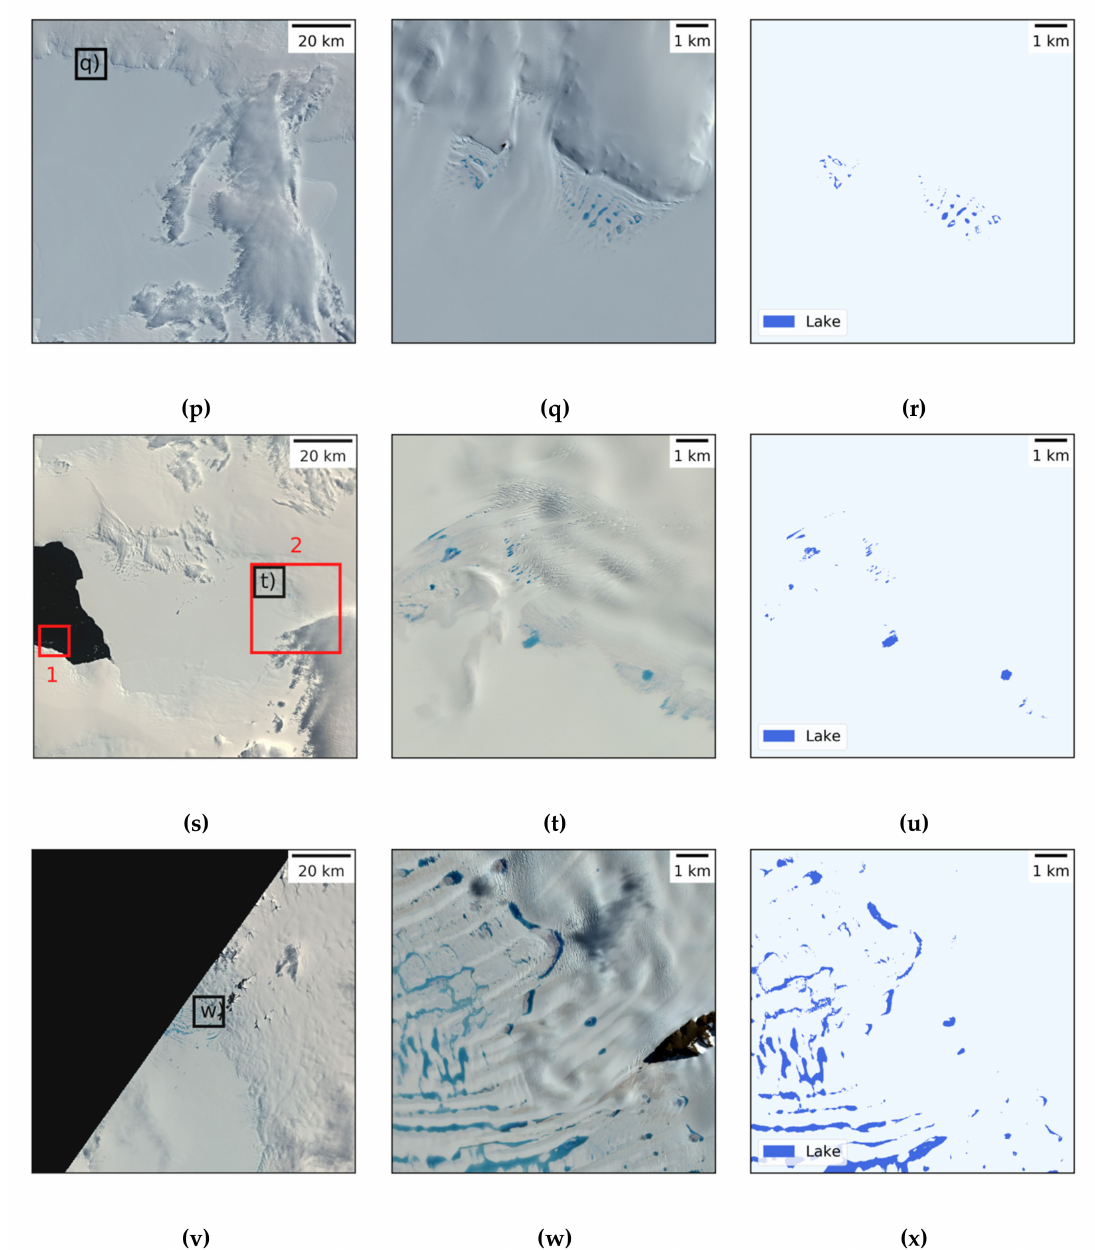
Figure 6. Sentinel-2 test scenes ( a , d , g , j , m , p , s , v ), image extracts ( b , e , h , k , n , q , t , w ) and final automated mapping results ( c , f , i , l , o , r , u , x ) for all test regions. ( a – c ) Nivlisen Ice Shelf. ( d – f ) Amundsen Bay. ( g – i ) Wilhelm II Coast. ( j – l ) Drygalski Ice Tongue. ( m – o ) Hull Glacier. ( p – r ) Abbott Ice Shelf. ( s – u ) Cosgrove Ice Shelf. ( v – x ) George VI Ice Shelf. The red boxes in ( s ) show the regions analyzed in Figure